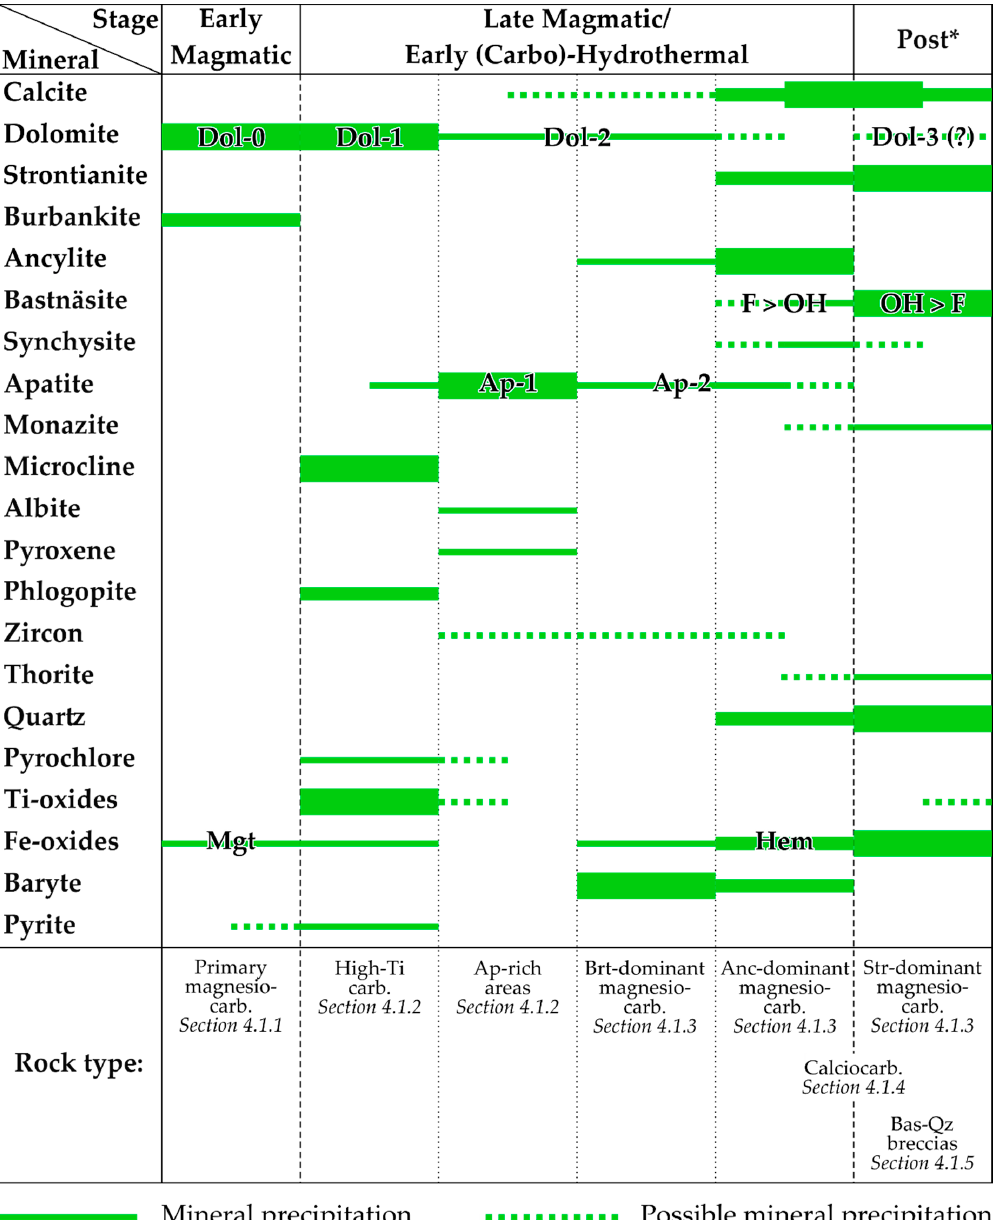
Figure 16. The proposed paragenetic sequence of minerals in the Petyayan-Vara carbonatites. Note: Post* includes both late (carbo)-hydrothermal and supergene stages. Line thickness indicates deposition intensity.